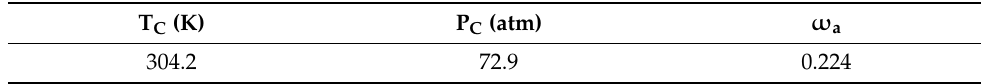
Table 8. Critical properties of the CO 2 obtained by PR EOS.